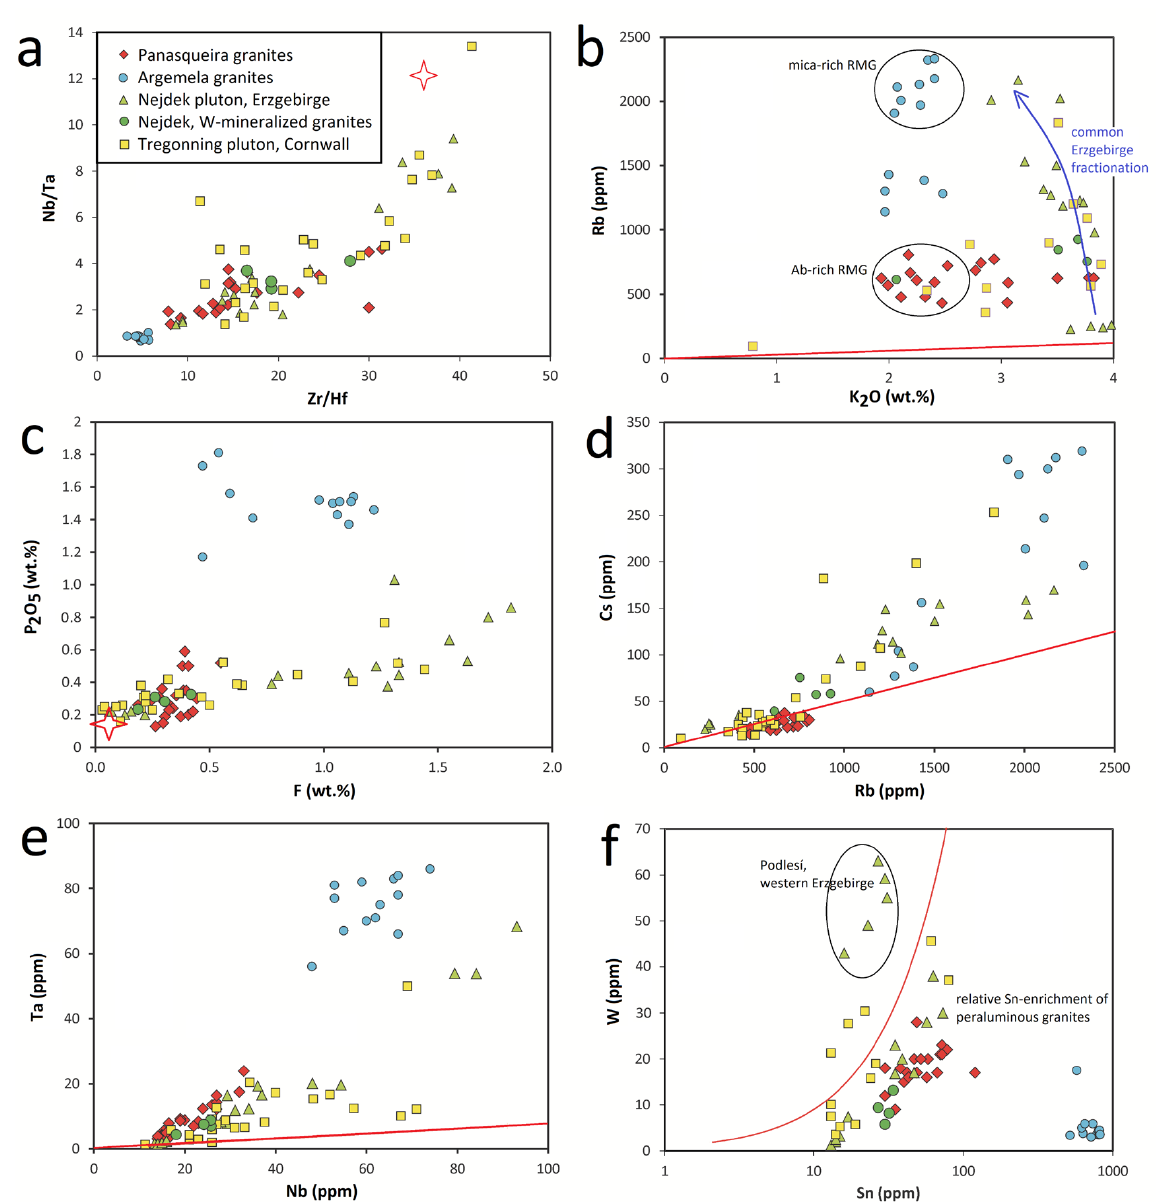
Figure 17. A comparison of bulk-rock contents of selected elements in European Variscan peraluminous granites: Panasqueira (this paper), Argemela [23], Land’s End pluton [51] and Tregoning pluton + Megiligar area [52] in Cornwall, and the Nejdek pluton [29] + associated W-producing subintrusions from the Erzgebirge (authors’ unpublished data): ( a ) Zr/Hf vs. Nb/Ta; ( b ) K vs. Rb; ( c ) P 2 O 5 vs. F; ( d ) Rb vs. Cs; ( e ) Nb vs. Ta; ( f ) Sn vs. W. Mean elemental ratios of the upper continental crust [50] are shown as a red line or an asterisk.